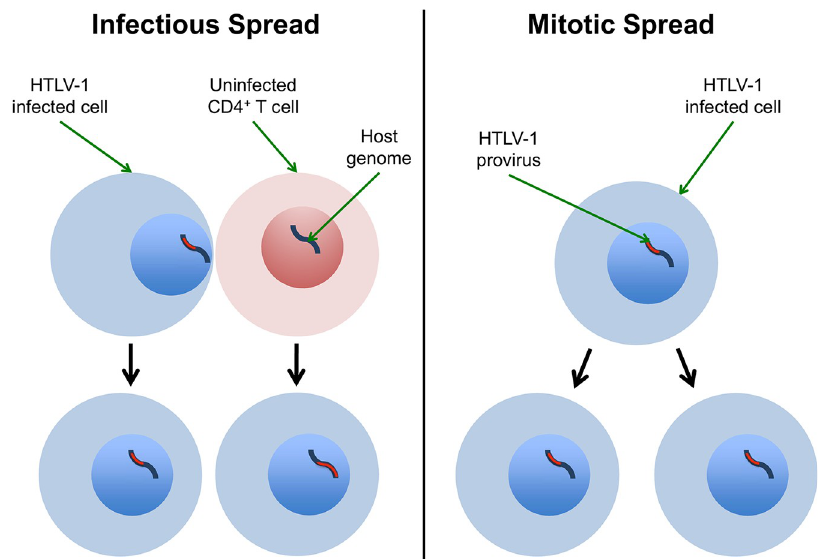
Fig 1. HTLV-1 infectious and mitotic spread schematic. Left column (Infectious spread): an HTLV-1-infected cell infects an uninfected CD4 + T cell (typically by cell-to-cell contact via the virological synapse, and potentially also via cell-free spread). The HTLV-1 provirus (red) integrates in a different genomic location in the newly infected cell, so infectious spread has resulted in two clones. Right column (Mitotic spread): An HTLV-1-infected cell divides, whereupon the provirus resides in the same genomic location in each daughter cell. The figure shows a single clone with two HTLV-1-infected cells.